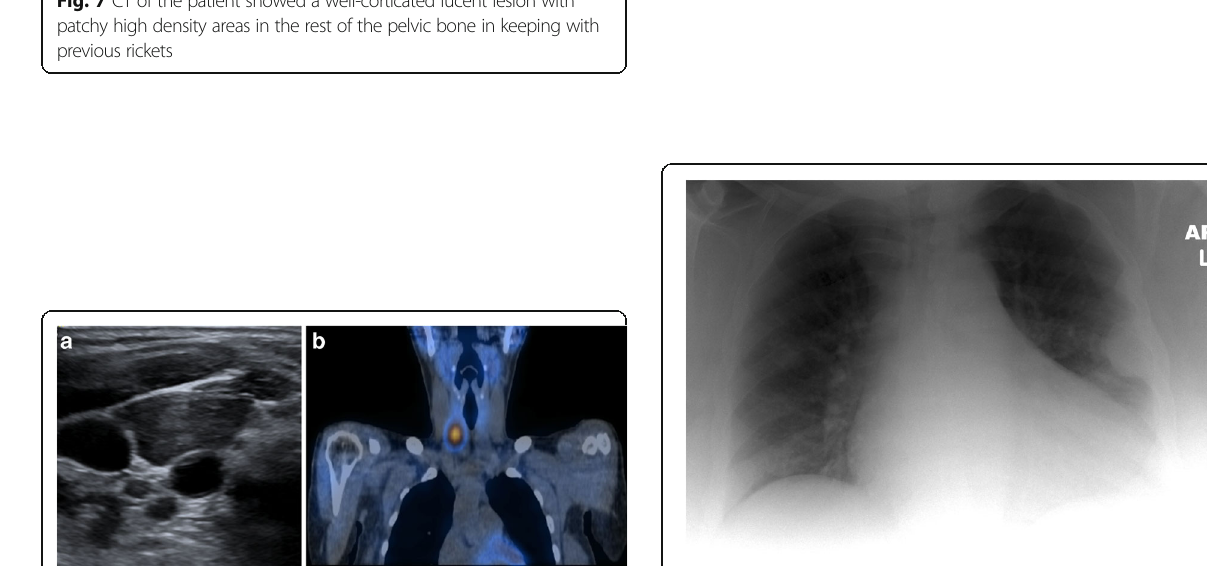
Fig. 8 a , b Ultrasound and SPECT/CT showed a 15-mm right inferior parathyroid adenoma with residual high uptake